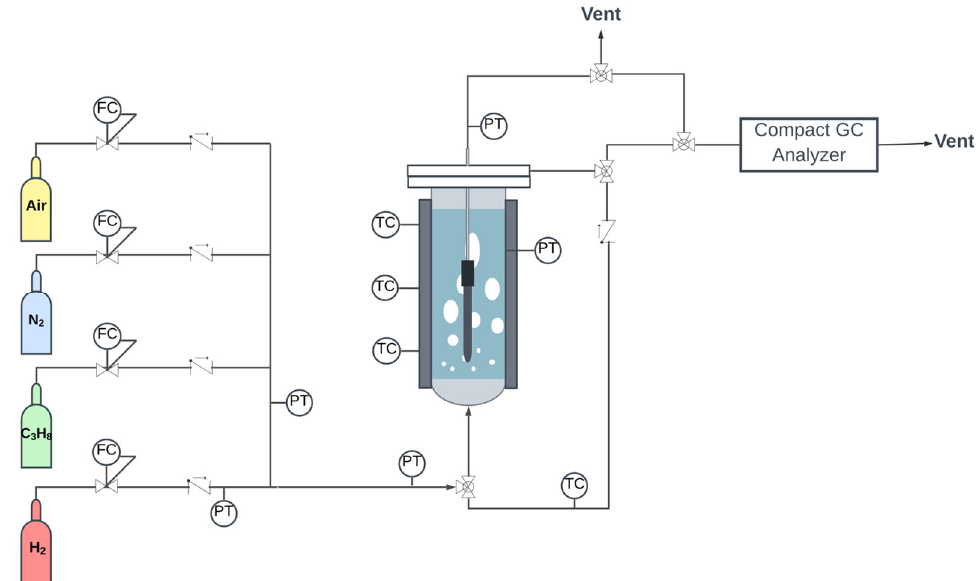
Figure 1. Schematic representation of the experimental setup for fluidization tests. FC indicates mass flow controllers, TC represents thermocouples, and PT indicates pressure transducers. flow controllers, TC represents thermocouples, and PT indicates pressure